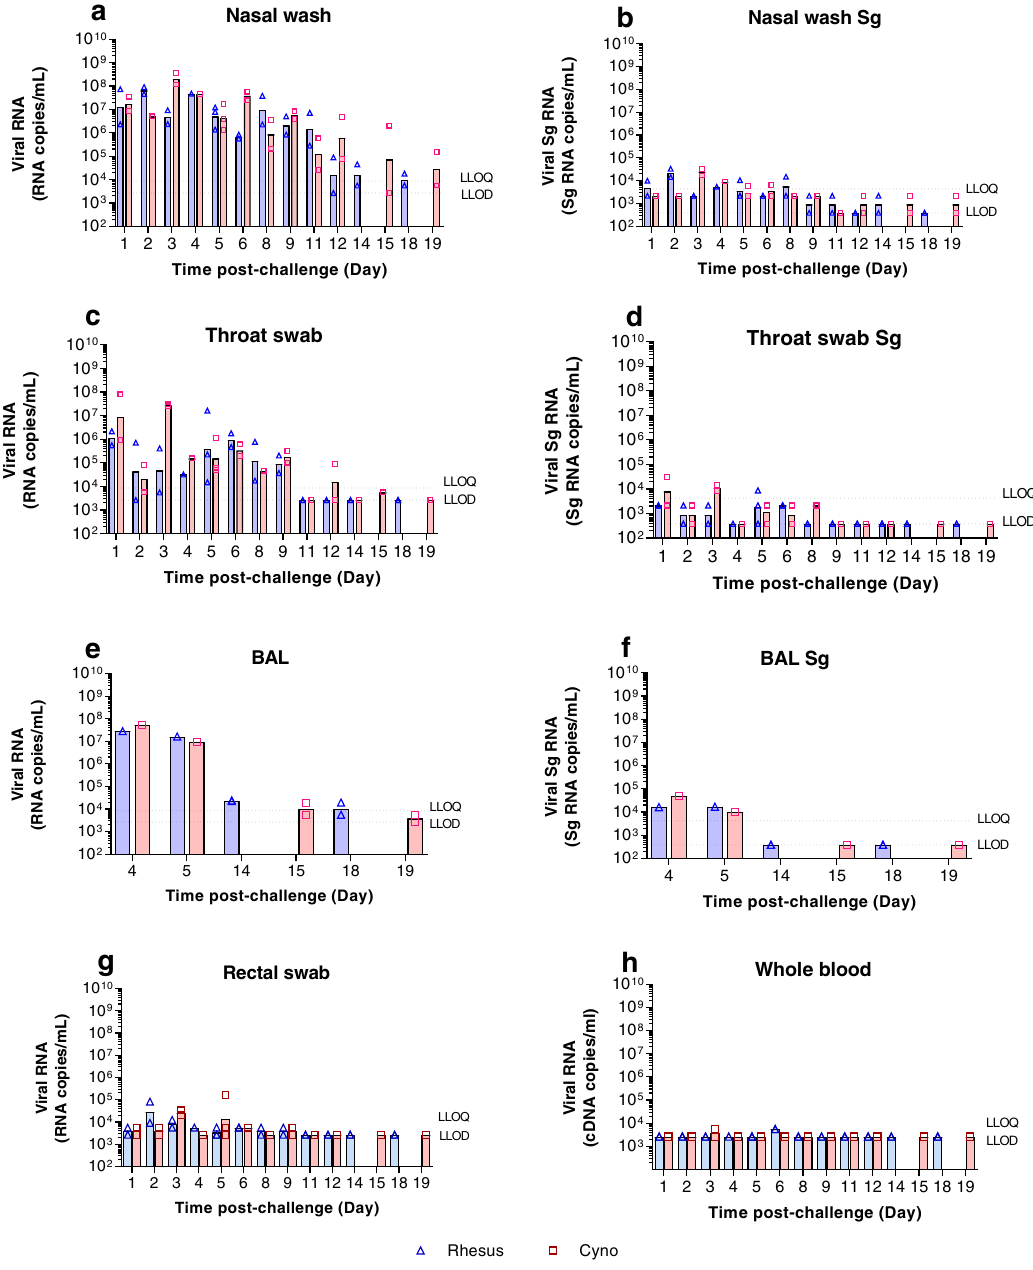
Fig. 3 Viral RNA detected by RT-qPCR. Viral load presented as the geometric mean of RNA copies/mL or individual values, with individual data points overlaid in rhesus macaques (blue) and cynomolgus macaques (red) in ( a ) nasal wash total RNA, ( b ) nasal wash Sg RNA, ( c ) throat swab total RNA, ( d ) throat swab Sg RNA ( e ) bronchoalveolar lavage (BAL) total RNA, ( f ) bronchoalveolar lavage (BAL) Sg RNA (numbers indicate days post-challenge the NHP was euthanised), ( g ) rectal swab total RNA, ( h ) whole blood total RNA. n = 2 macaques per group/species at 1, 2, 3, 6, 8, 9, 11, 12, 14, 15, 18 and 19 dpc; n = 1 at 4 dpc; n = 3 at 5 dpc (for BAL; n = 1 at 4 and 5 dpc and n = 2 at 14,15, 18 and 19 dpc). Bars show median values. Dashed lines highlight the LLOQ (lower limit of quanti fi cation, 8.57 × 10 3 copies/mL for total RNA and 1.29 × 10 4 copies/mL subgenomic RNA) and LLOD (lower limit of detection, 2.66 × 10 3 copies/mL for total RNA, 1.16 × 10 3 copies/mL for subgenomic RNA). Positive samples detected below the LLOQ were assigned the value of 5.57 × 10 3 copies/mL for total RNA and 12.86 × 10 4 copies/mL subgenomic RNA. Viral RNA was not detected in naïve animals. Samples for RT-qPCR and sgPCR were assayed in duplicate against a standard curve in triplicate.